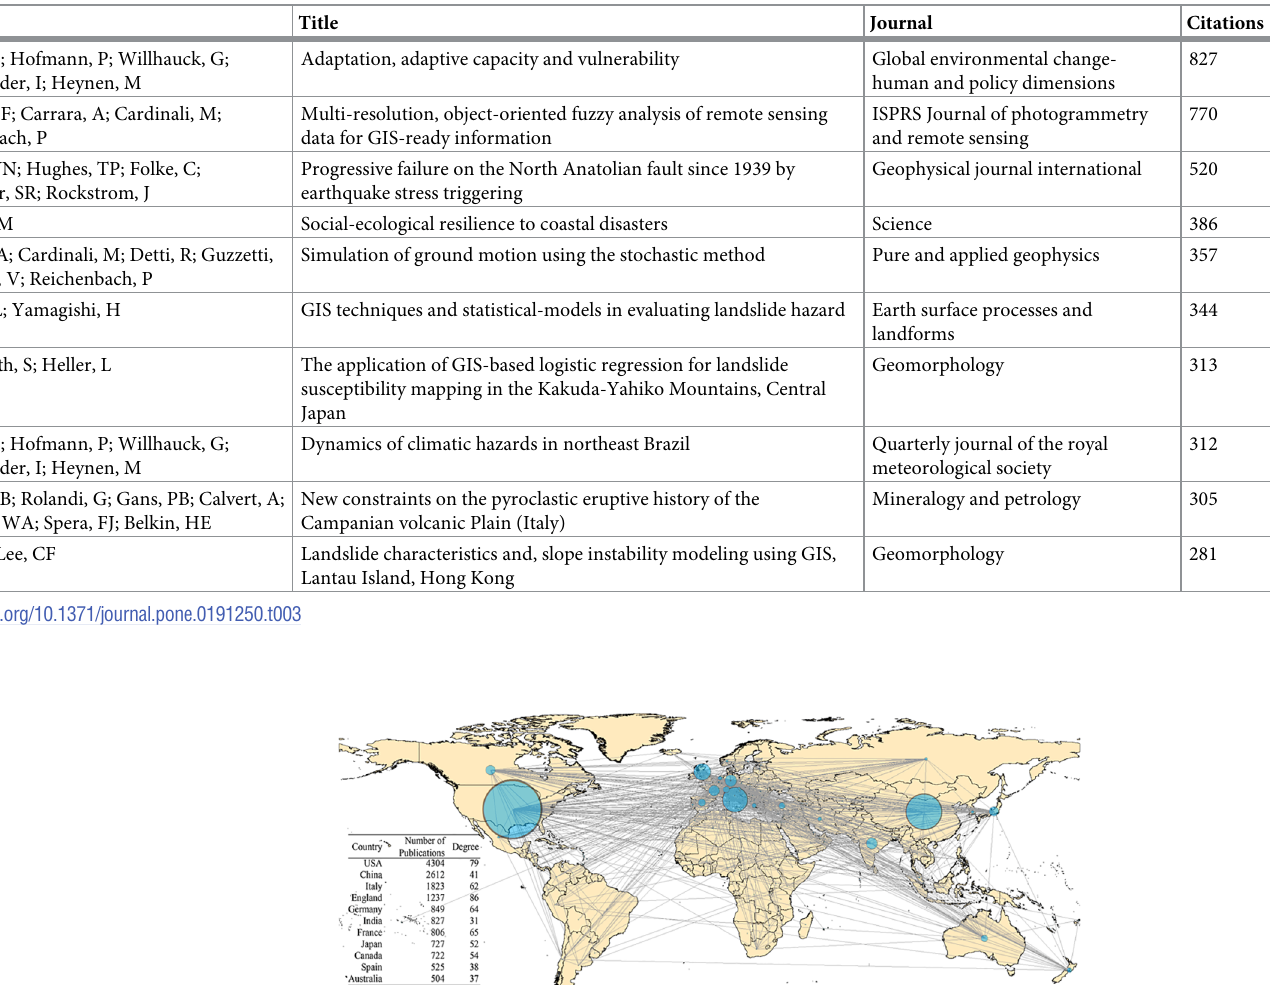
Table 3. Top 10 cited research articles related natural disaster and their citations (with descending order).